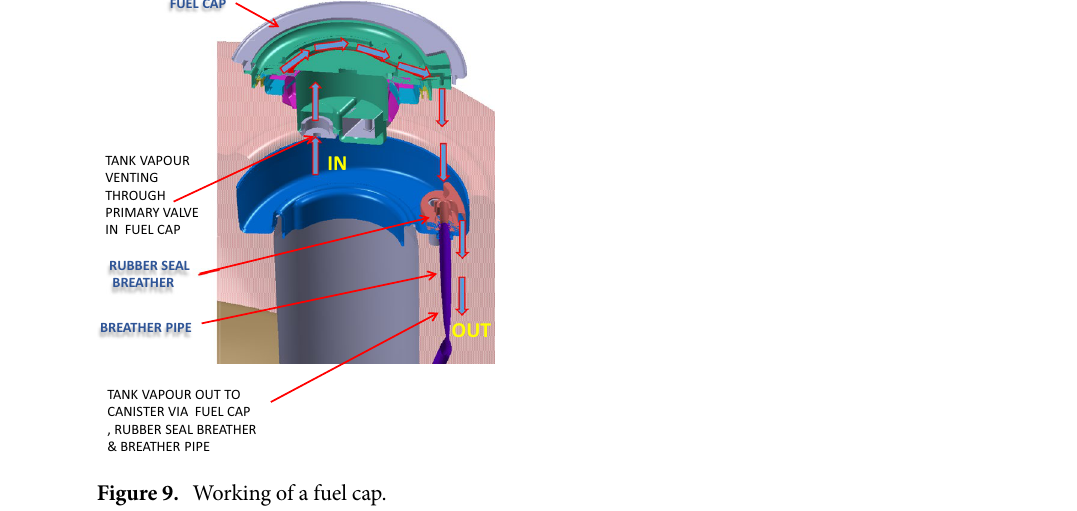
Figure 9. Working of a fuel cap.